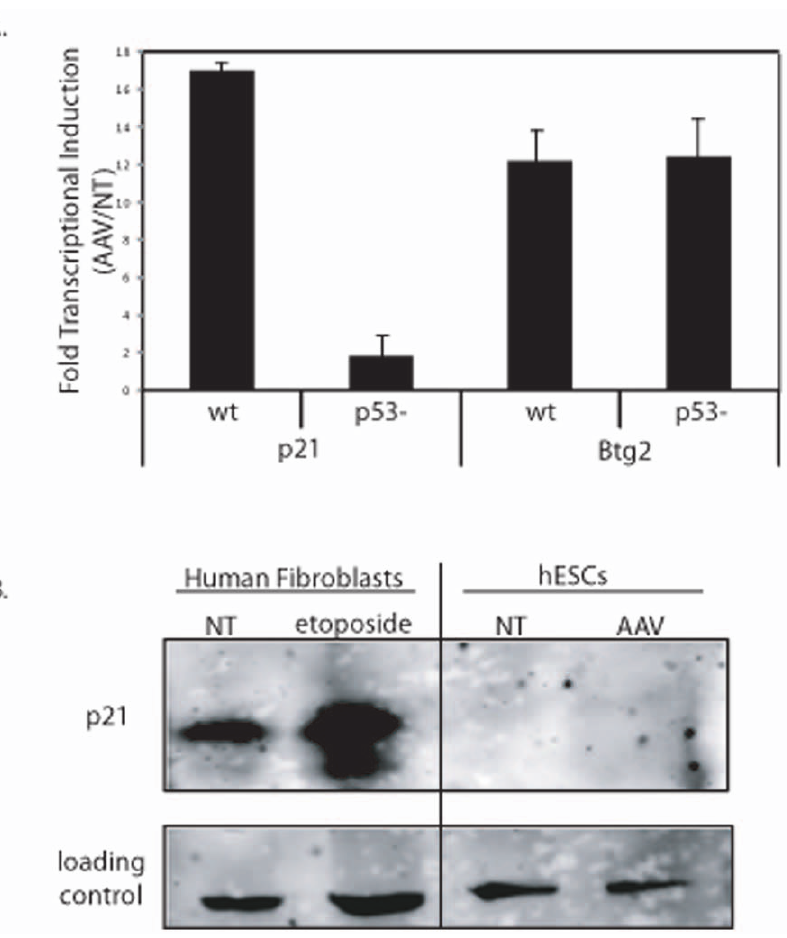
Figure 5. p53 Transactivation Occurs Following Recombinant AAV Infection. (A) Fold induction of p21 and Btg2 transcripts via quantitative PCR following rAAV infection. Data is presented as the value determined for hESCs infected with 100,000 AAV3B vectors 8 h post-infection divided by the transcript amount for hESCs not treated. Values were determined in both H9s and H9s with p53 knocked down as described in text (p53-). A significant difference was noted only for p21 transcript levels in the absence of p53 (p-value , 0.005). B) Western blot analysis of p21 abundance following rAAV infection (8 h post-infection). Human fibroblasts treated with the DNA damaging agent etoposide was used as an antibody control. The results are averaged from at least 3 replicates for each treatment group and the standard deviation is